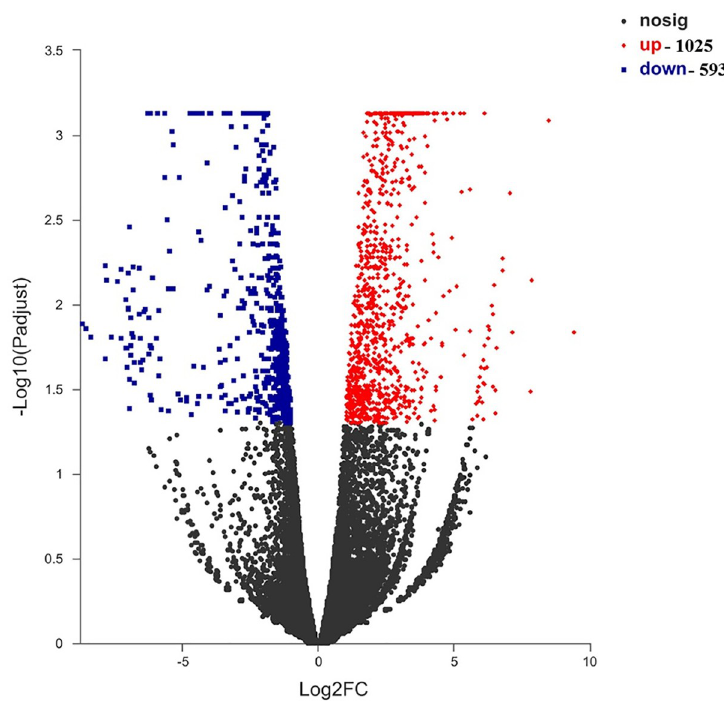
Fig 3. DEGs analysis and volcano plot for fast- (F) and slow-growth (S) groups of hybrid mandarin fish. The x-axis is the value of Log2 (Fold Change), and the y-axis is the value of -Log10 (padjust). The red and blue dots reveal the up- and down-regulated DEGs, the black dots reveal non-significantly